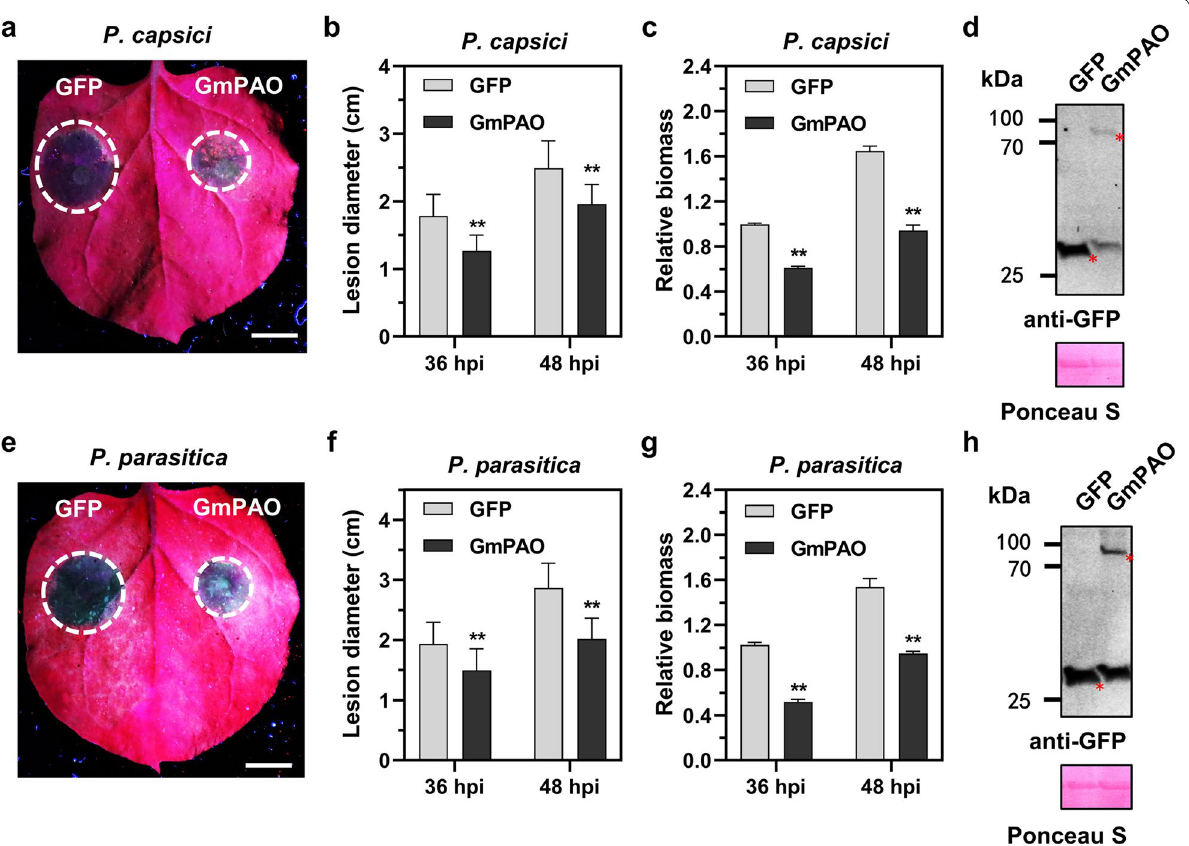
Fig. 6 GmPAO enhances resistance to P. capsici and P. parasitica infections in N. benthamiana . a , e Lesions caused by P. capsici ( a ) or P. parasitica ( e ) on N. benthamiana leaves expressing GFP or GmPAO genes. GFP was used as a negative control. Photos were taken at 36 hpi. Scale bars, 1 cm. b , f Comparisons of the lesion diameter caused by P. capsici ( b ) or P. parasitica ( f ). Error bar represents mean g Relative pathogen biomass quantified by genomic qPCR. Error bar represents mean immunoblot showing the levels of GFP and GmPAO after transient expression in N. benthamiana leaves. Proteins were stained with Ponceau S to confirm equal loading. All the experiments were performed three times (biological replicates) with similar results. The data in b , c , f , and g were analyzed by Shapiro–Wilk test to determine the Normality and Lognormality Tests across groups, and then analyzed by unpaired t test for groups that had passed the normality test (** P < 0.01). The exact n, SD values, and P values are shown in the